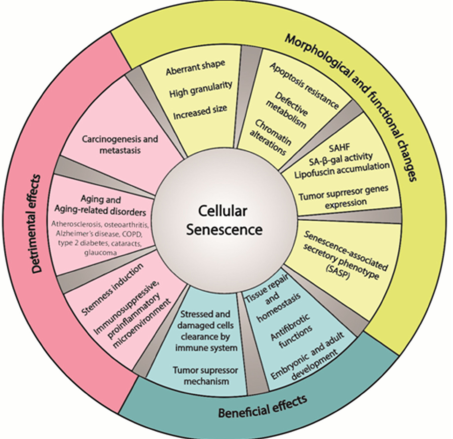
Figure 1. Characteristics, advantages and disadvantages of cellular senescence. Note: COPD: chronic obstructive pulmonary disease; SAHF: senescence-associated heterochromatin foci; SASP: Senescence- associated secretory